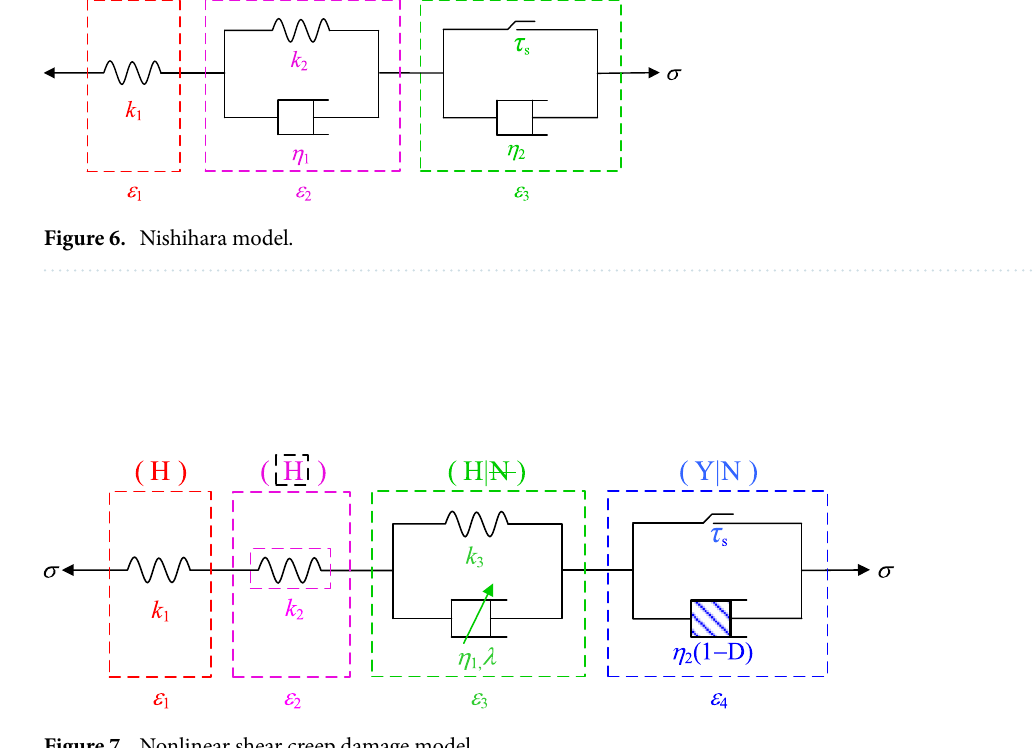
Figure 7. Nonlinear shear creep damage